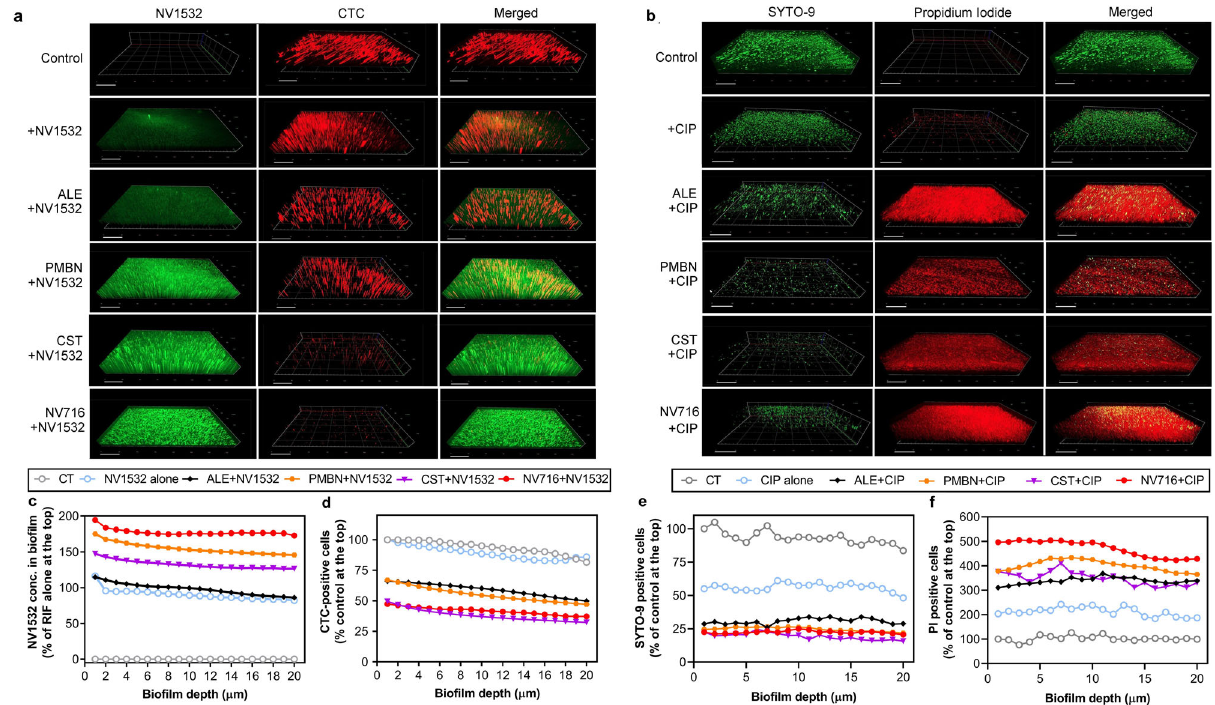
Fig. 9 Confocal images of bio fi lms of PAO1 exposed to antibiotics and potentiators. Potentiators were used in the conditions described in Fig. 8 (alexidine [ALE, 12 µ M], polymyxin B nonapeptide [PMBN, 30 µ M], colistin [CST, 1 µ M]; NV716 50 µ M). a Bio fi lms incubated with NV1532 ( fl uorescent derivative of rifampicin) at 100 mg/L alone or with potentiators, with fl uorescence of NV1532 recorded in the green channel and fl uorescence of CTC in the red channel. b Bio fi lms incubated with cipro fl oxacin at 50 mg/L alone or with potentiators, with fl uorescence of SYTO-9 recorded in the green channel and fl uorescence of propidium iodide (PI) in the red channel. Scale bar: 30 µ m. c , d quantitative analysis of the data from panel a , showing the fl uorescence of NV1532 or of CTC, respectively, in percentage of the value measured at the top of the bio fi lm. e , f quantitative analysis of the data from panel b , showing the fl uorescence of SYTO-9 or of PI, respectively, in percentage of the value measured at the top of the bio fi